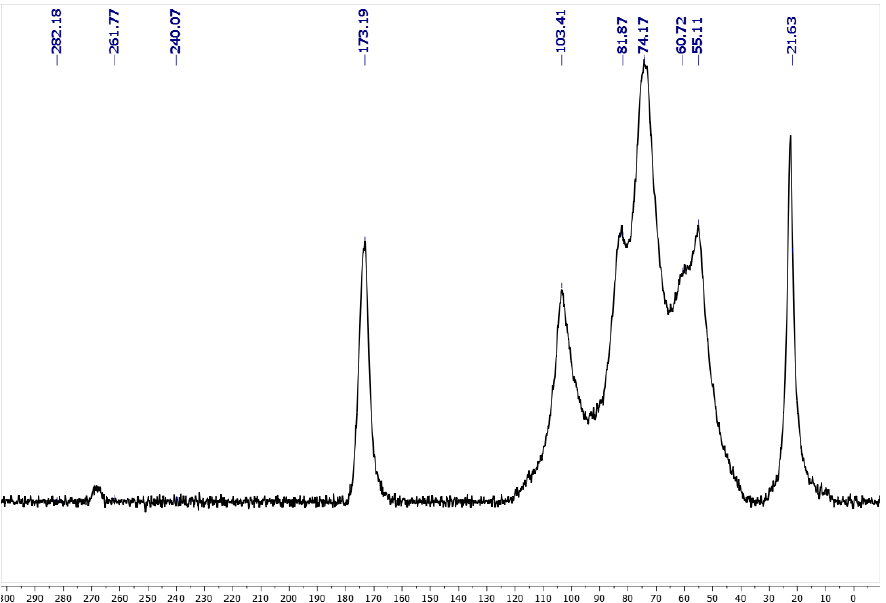
Figure 2. Solid-state CP–MAS 13 C NMR of chitin extracted from Vespa velutina. 13 C NMR (126 MHz): δ 267.96, 173.17, 104.12, 82.74, 75.34, 60.34, 55.94, 22.79.